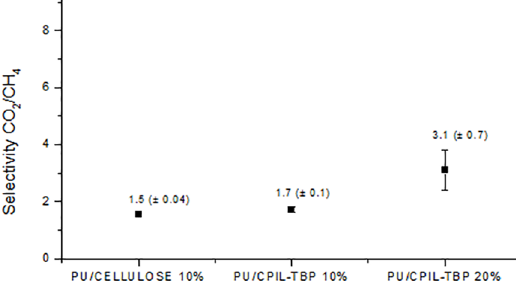
/CH selectivity values at 2.0 2 4